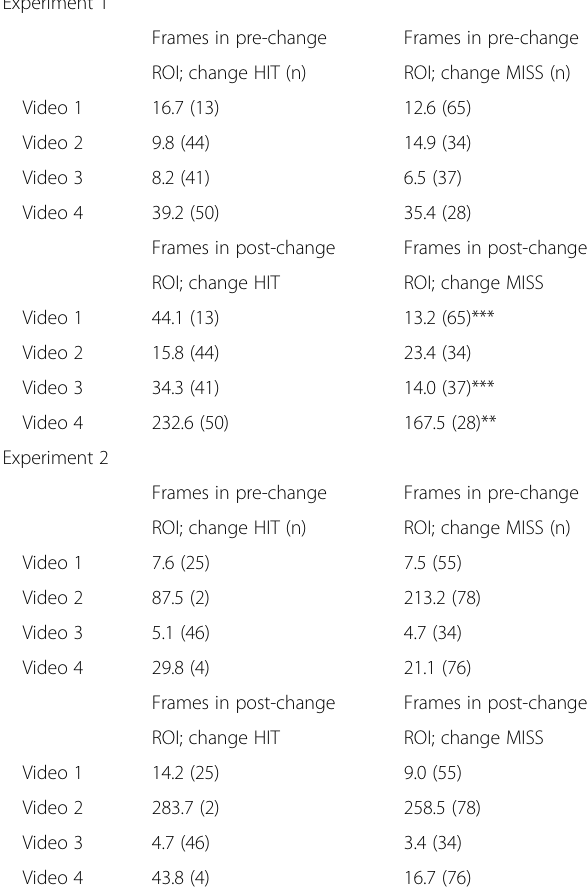
Table 1 Relationship between gaze duration in pre- and post- change ROIs and change detection for each video Experiment 1 Frames in pre-change Frames in